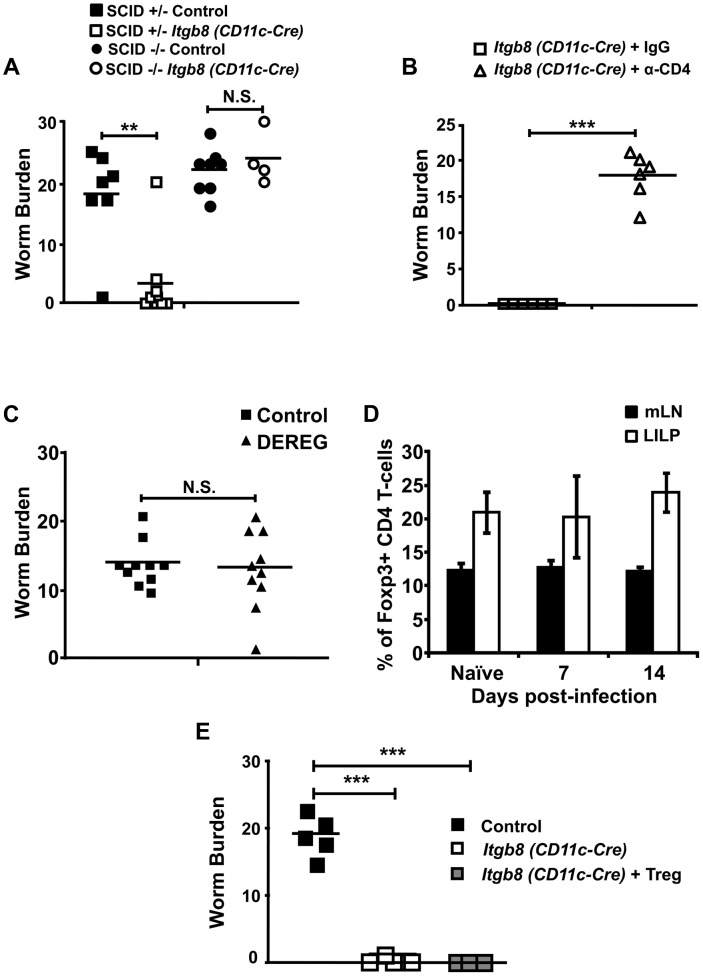
Protection from chronic T. muris infection in mice lacking the TGFβ-activating integrin αvβ8 on DCs is dependent on CD4+ T-cells, but does not involve Foxp3+ Tregs.(A) Worm burdens from control and Itgb8 (CD11c-Cre) mice crossed onto a SCID background analysed at day 32 post-infection (p.i.) with a chronic dose of T.muris eggs. Data (n = 4–9 mice per group) are from two independent experiments performed. (B) Worm burdens from Itgb8 (CD11c-Cre) mice infected with a chronic dose of T.muris eggs and treated with 2 mg of control IgG or anti-CD4 antibody (YTS191) analysed at day 17 p.i. Data (n = 6 mice per group) are from two independent experiments performed. (C) Control and DEREG mice were infected with a chronic dose of T. muris eggs, injected i.p. with 200 ng diphtheria toxin every 2 days (starting 2 days before infection) and worm burdens analysed at day 14 p.i. Data (n = 10 mice per group) are from two independent experiments performed. (D) Percentage of Foxp3+ Tregs of CD4 T-cells in mLN, IEL and LILP populations during T. muris infection as analysed by flow cytometry. Data (n = 7–11 mice per group) are from four independent experiments. (E) Caecal lamina propria worm burdens in control, Itgb8 (CD11c-Cre) and Itgb8 (CD11c-Cre) mice injected with 0.5×106 GFP-Foxp3+ CD4 T-cells 3 days prior to infection. All mice received a chronic dose of T. muris and were analysed at day 14 p.i. for worm burden or day 3 p.i. for reconstitution. Data (n = 3–4 mice per group) are from three independent experiments. **, P<0.01; or ***, P<0.005, N.S., not significant via Kruskal–Wallis (D) and Student's t-test (A, B, C and E) for the indicated comparisons between groups, error bars represent SE of means.